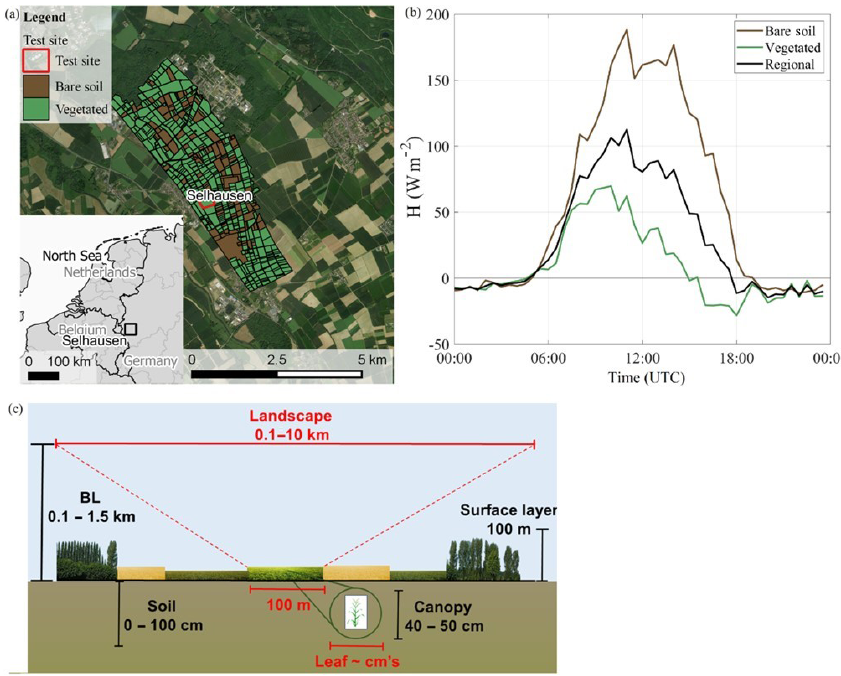
Figure 1. (a) Aerial view (Bing Maps, © 2019 Microsoft Corporation © 2019 DigitalGlobe © CNES (2019) Distribution Airbus DS) of the observation area. The ICOS Selhausen test site is located in the middle of the 10 × 10km map section. The surrounding agricultural area was classified into the categories bare soil (including “late crops” following Table 3) and vegetated (“early crops”, forest and grassland following Table 3) during the IOP 1. (b) Corresponding sensible heat flux ( H ) during IOP 1, whereby H of bare soil and vegetated area were measured and the regional average was estimated as weighted average (60% and 40% for vegetated and bare soil, respectively). (c) Schematic sketch of horizontal (red) and vertical (black) length scales influencing the measurements. The larger indicated horizontal and vertical scales indicate the spatial scales of boundary layer dynamics. Horizontally, the 100m scale is the size of the field hosting the ICOS test